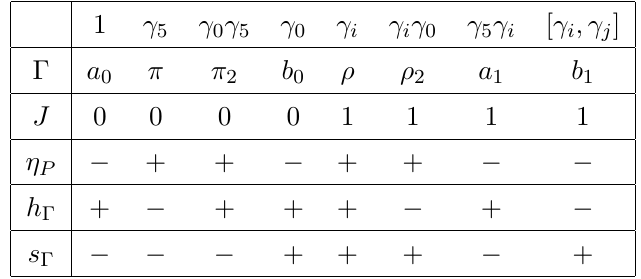
Table 3 . For di(cid:11)erent Dirac gamma matrices, we show the notation (cid:0) used to denote the gamma matrix, the continuum spin J , the parity factor (cid:17) P , the hermiticity factor h (cid:0) and the spin coupling symmetry s (cid:0)